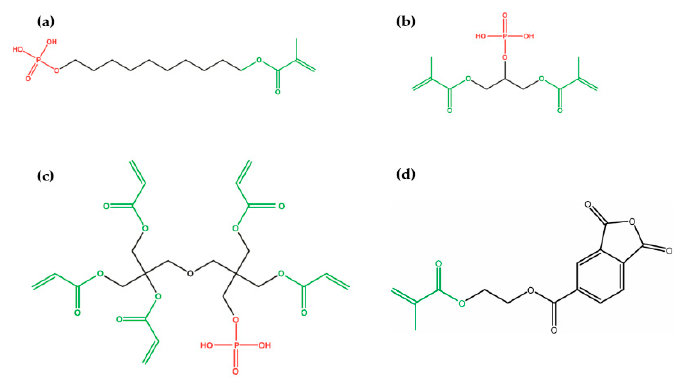
Figure 5. Chemical structure of the acidic monomers used in some universal adhesive systems: ( a ) 10-methacryloyloxydecyl dihydrogen phosphate; ( b ) glycerol phosphate dimethacrylate; ( c ) dipen- taerythritol penta-acrylate phosphate; ( d ) 4-methacryloxyethyl trimellitic anhydride.